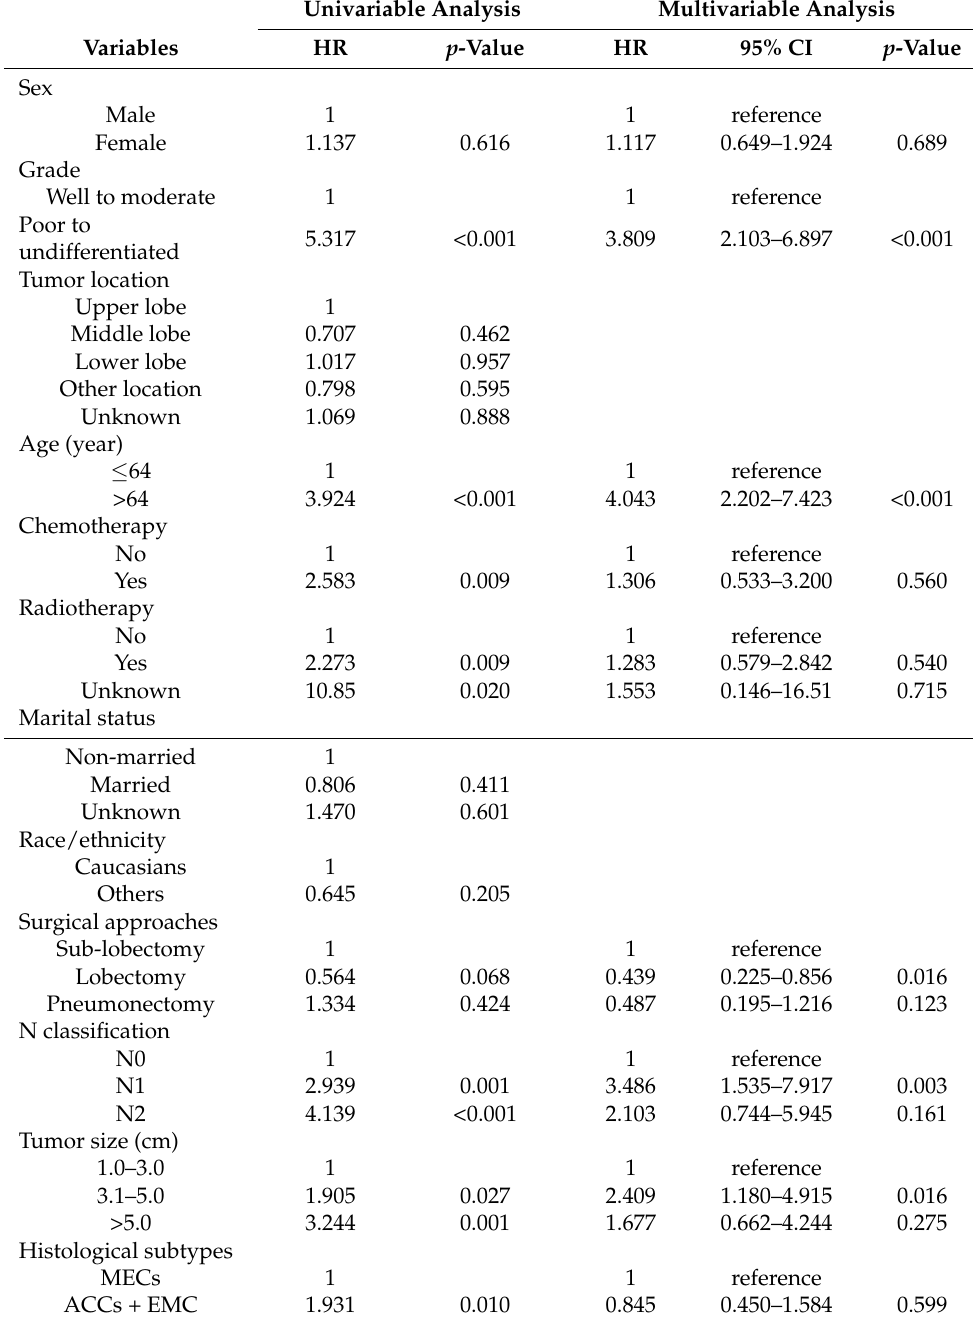
Table 4. Univariable and multivariable Cox proportional hazard regression analyses of postoperative prognostic factors in salivary gland-type carcinoma patients. Univariable Analysis Multivariable